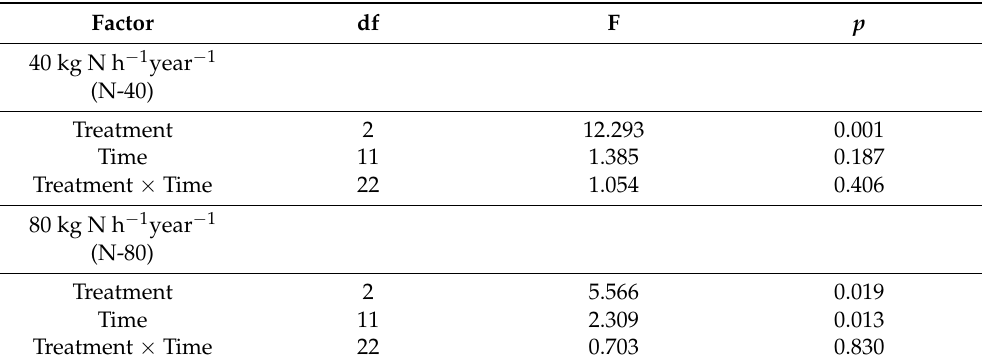
Table 2. Repeated measures ANOVA analyses for all treatments during phase 2 of our